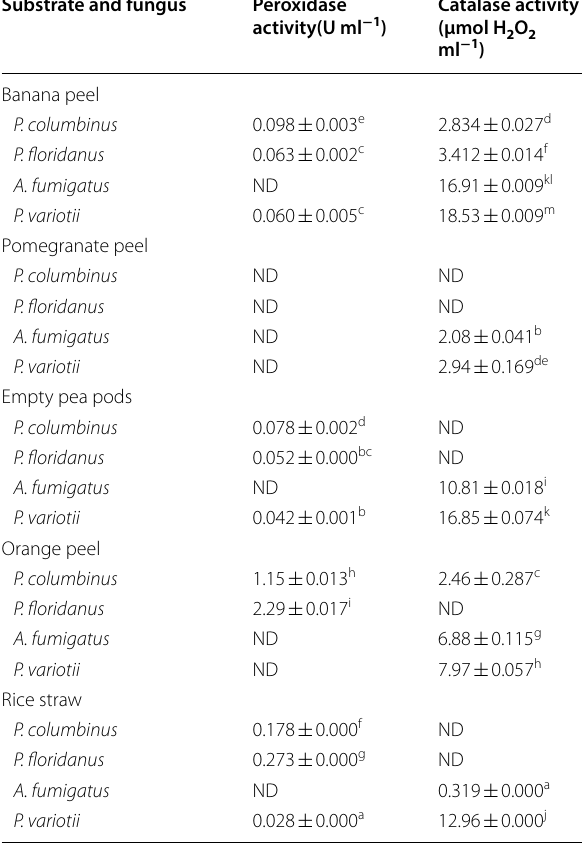
Each value is the mean of three replicates not significantly different at P < 0.05 ND not detected